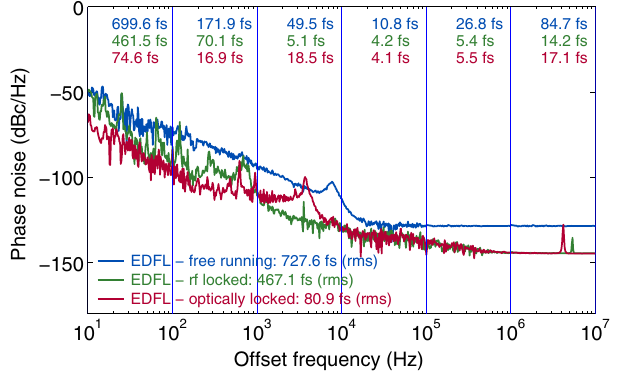
FIG. 38. Long-term in-loop optical lock stability of the EDFL OMO [109]. The integrated timing jitter over 60 minutes is 4.6 fs (rms) in the range between 1 Hz and 100 kHz. The clustering of the stability values at distinct values is a consequence of the limited resolution of the sampling clock.